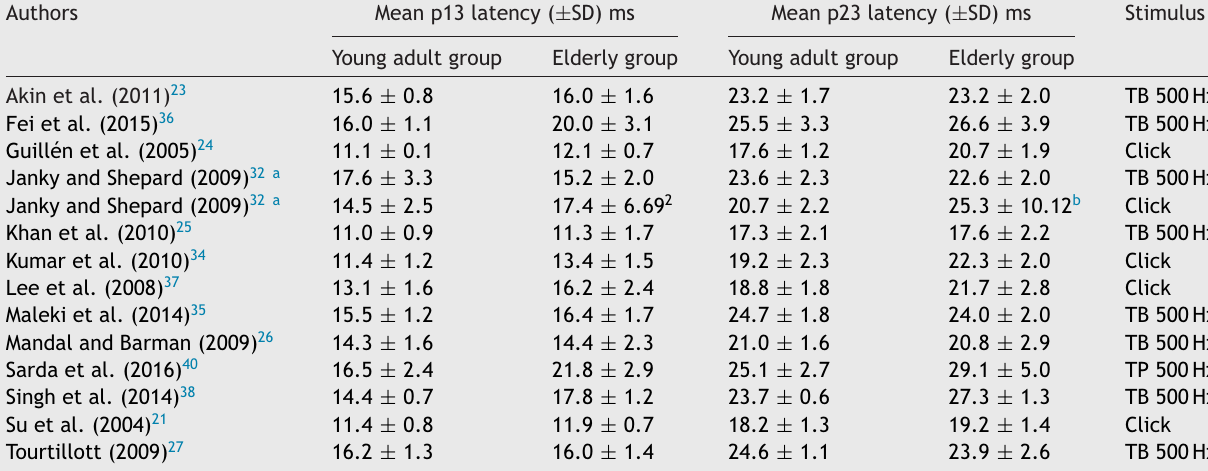
Means and standard deviations of cVEMP p13 and n23 latencies, for young adults and for the elderly, per study.